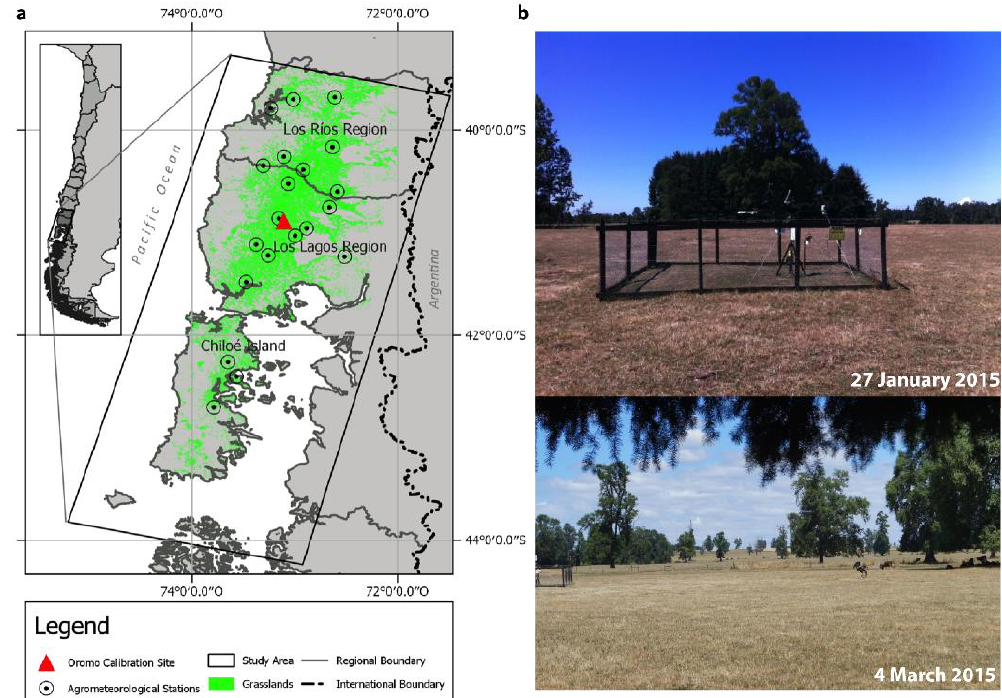
Figure 1. Study region and view of pastures at Oromo calibration site during the drought of the austral summer 2014 – 2015. ( a ) Temperate pastures in southern Chile (green shading), location of the agrometeorological monitoring stations (circles) and the Oromo calibration site (red triangle). ( b ) View of the monitoring station in Oromo and surrounding pastures during the middle and later part of the summer drought of 2014 – 2015.